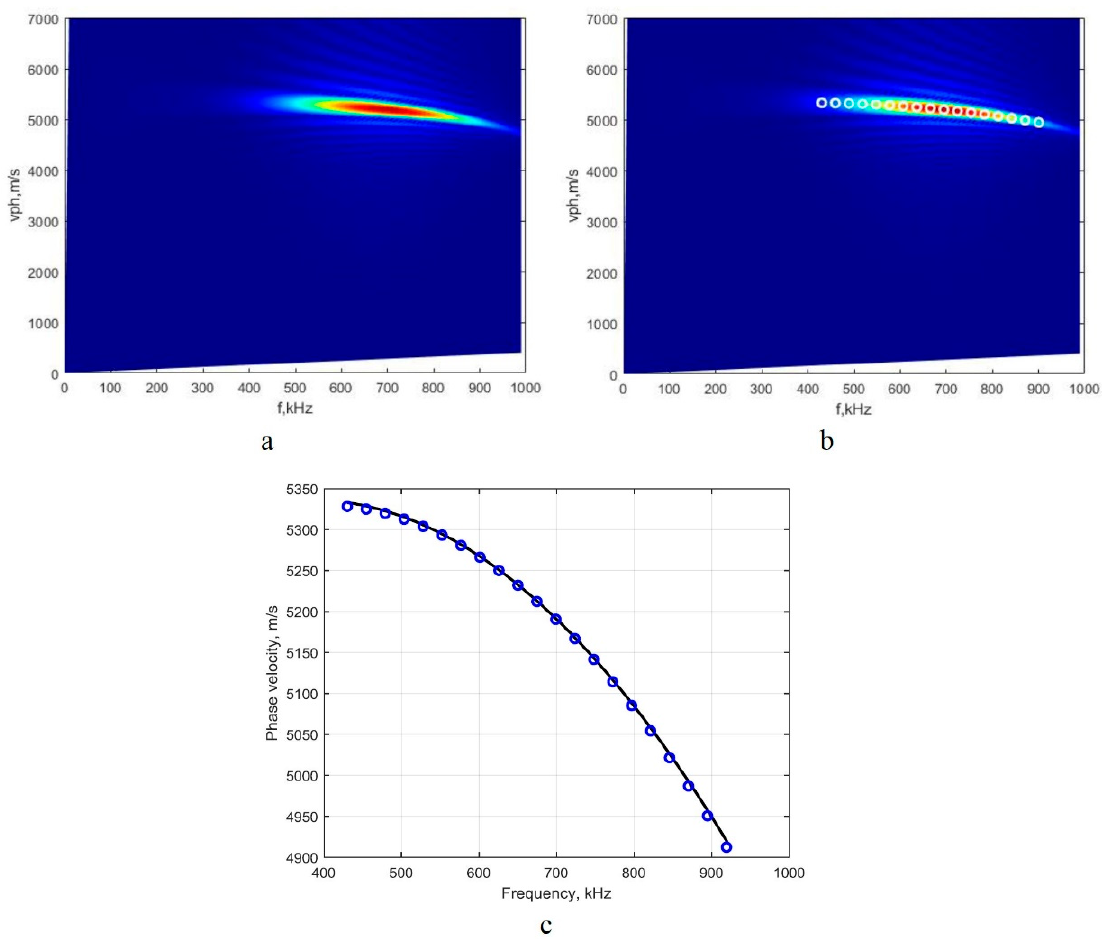
Figure 7. The image of the S 0 -mode phase-velocity dispersion curve segment obtained in the 700 kHz range by the 2D-FFT method ( a ), the quantitative values of the dispersion curve segment that were reconstructed by using the analyzed method ( b ), and the dispersion curve segment acquired by using the analytical method (the solid line) and reconstructed by using the proposed algorithm (circles) ( c ).